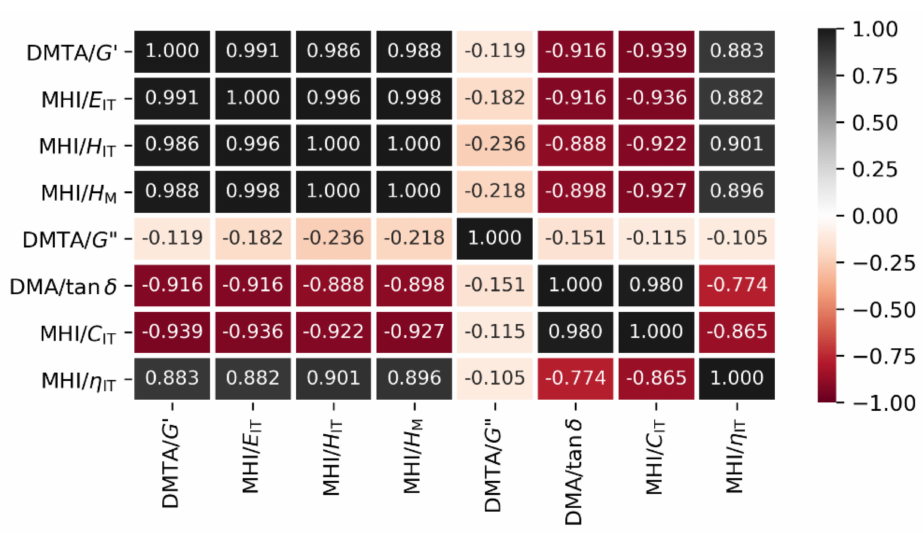
Figure A6. Complete results of DMTA measurements for all TPS/PCL blends in temperature range − 80–160 ◦ C: ( A ) storage modulus, ( B ) loss modulus, ( C ) absolute value of complex modulus, and ( D ) damping factor.